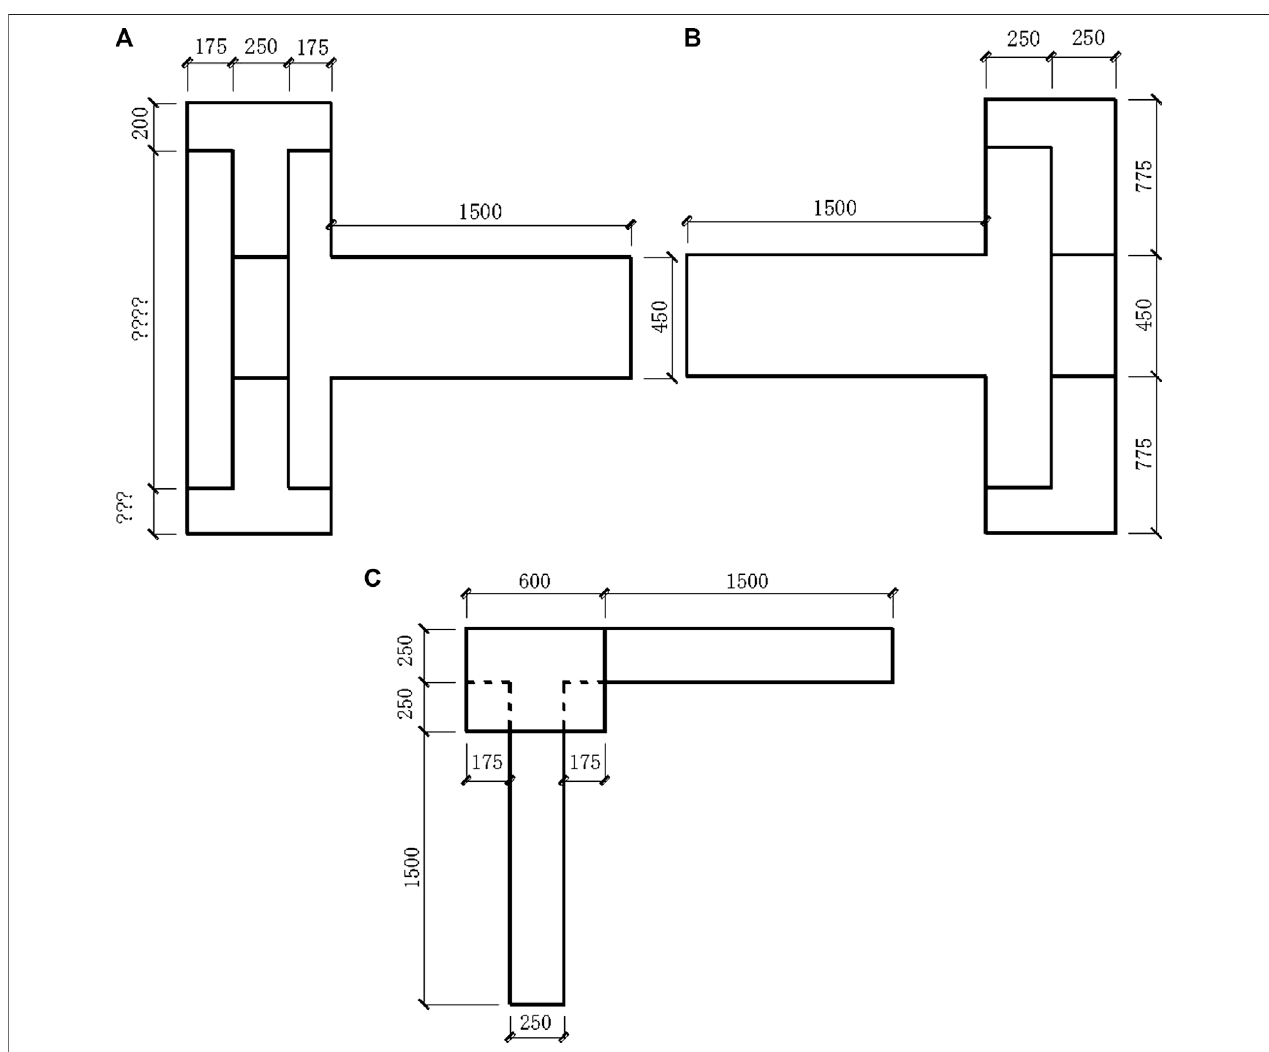
FIGURE 1 | Three-dimensional drawings of specimens. (A) Front elevation drawing, (B) left-side drawing, and (C) planar